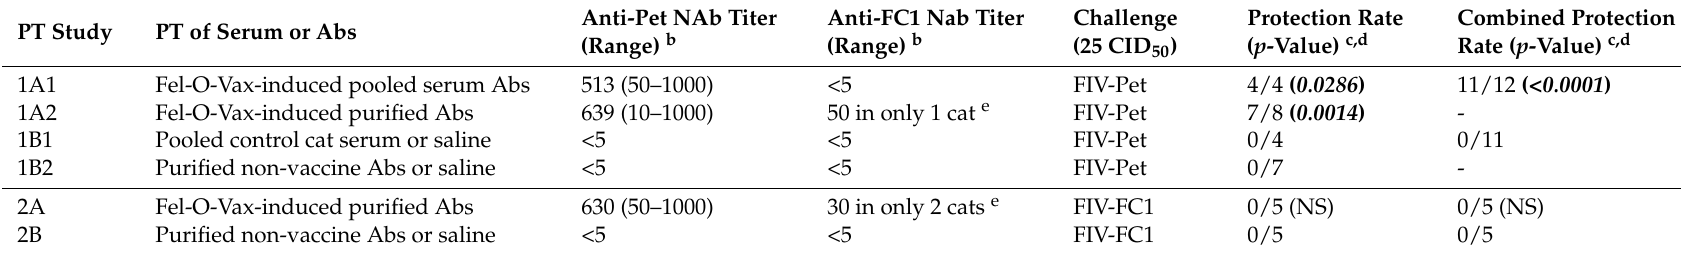
a Table 4 adapted from reference [48]. b Average neutralizing antibody (NAb) titer and range to either FIV